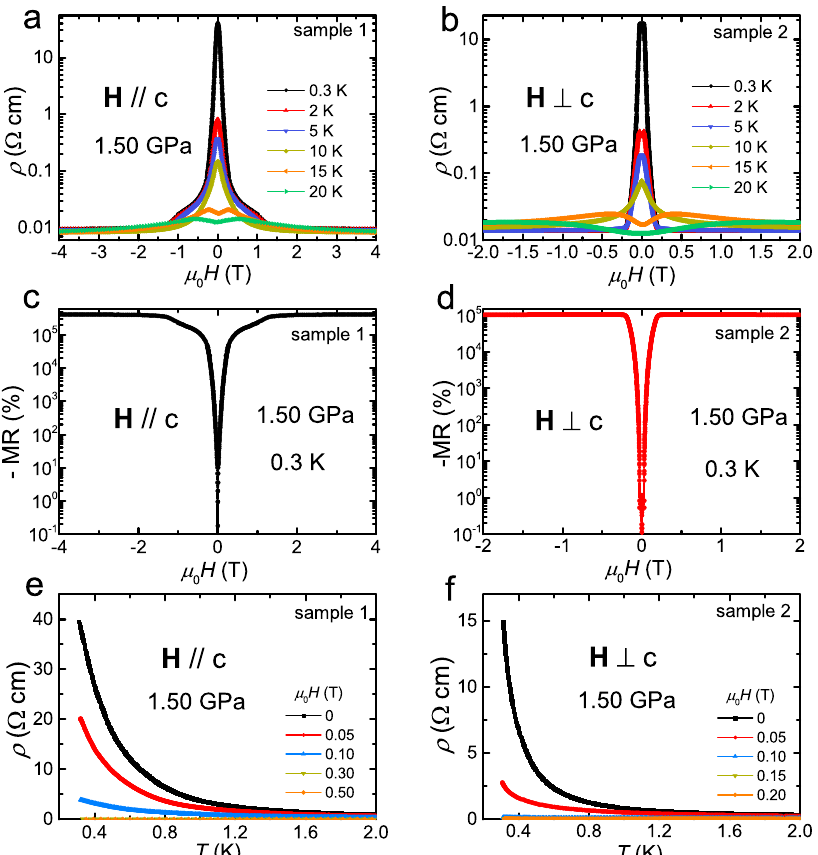
Fig. 3 Colossal magnetoresistance in EuCd 2 As 2 under 1.50 GPa. Field-dependence of the resistivity ρ ( H ) at various temperatures, for fi elds ( a ) along the c -axis, and ( b ) in the ab -plane, plotted on a log scale. The magnetoresistance (MR) under 1.50 GPa of pressure at 0.3 K, de fi ned as [ ρ ( H ) − ρ (0)]/ ρ (0), for ( c ) c -axis and ( d ) ab -plane magnetic fi elds. The fi elds needed to achieve − 10 2 %, − 10 3 %, − 10 4 % and − 10 5 % magnetoresistance are respectively 0.05 T, 0.10 T, 0.18 T and 0.42 T in ( c ), and respectively 0.04 T, 0.06 T, 0.10 T, and 0.22 T in ( d ). Temperature- dependence of the resistivity ρ ( T ) under various magnetic fi elds along ( e ) the c -axis, and in ( f ) the ab